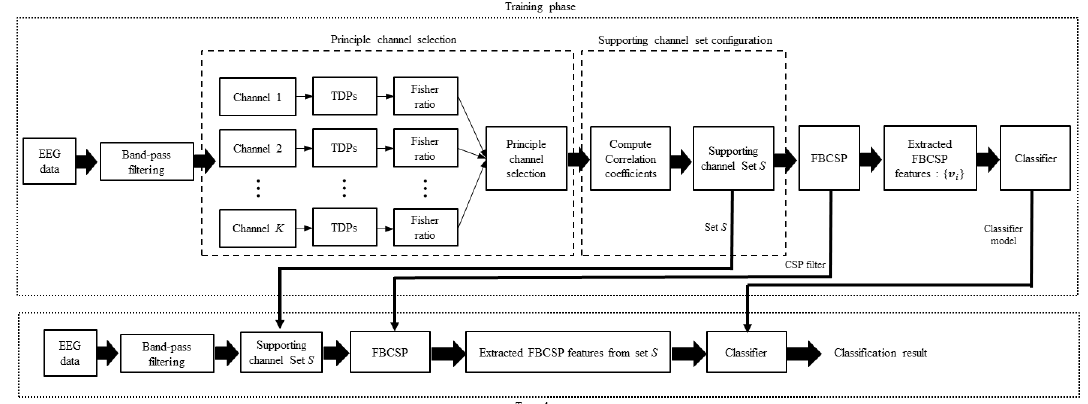
Figure 1. Block diagram of the proposed